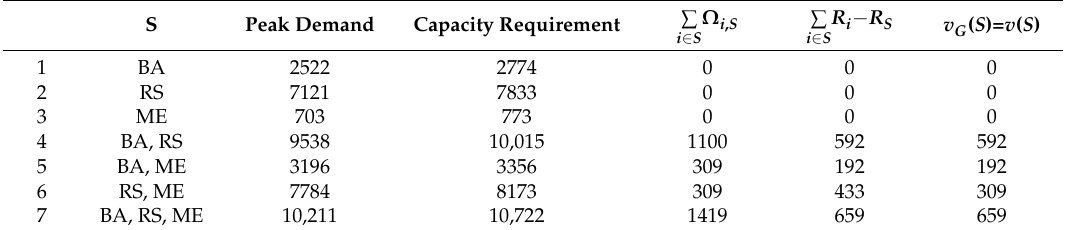
Table 2. Data and characteristic values for the 3-country game (in MW).